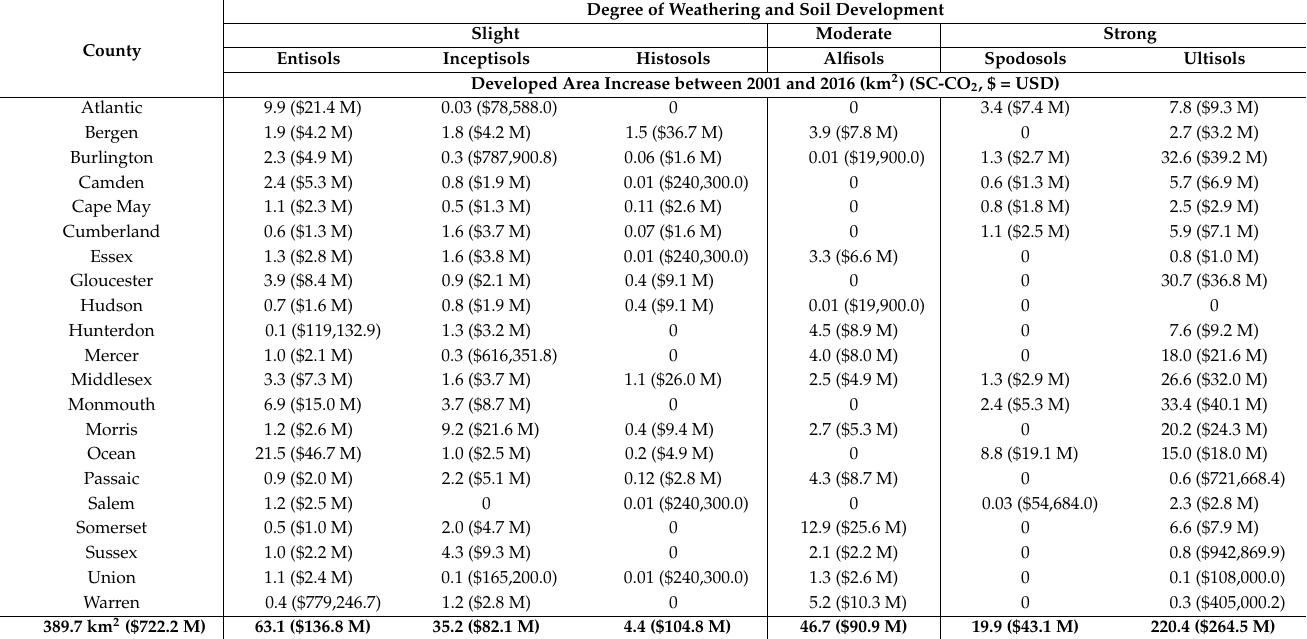
Table 11. Increases in land development (LULC: developed open space, developed medium intensity, developed low intensity, and developed high intensity) and maximum potential for realized social costs of C due to complete loss of total soil carbon (TSC) of developed land by soil order and county in New Jersey (USA) from 2001 to